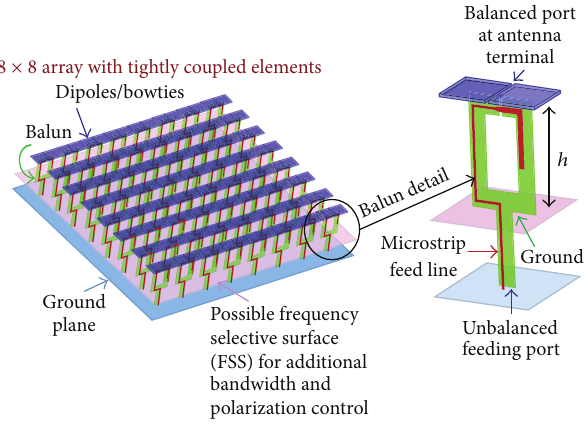
Figure 2: Geometrical configuration of the tightly coupled array discussed in [48,